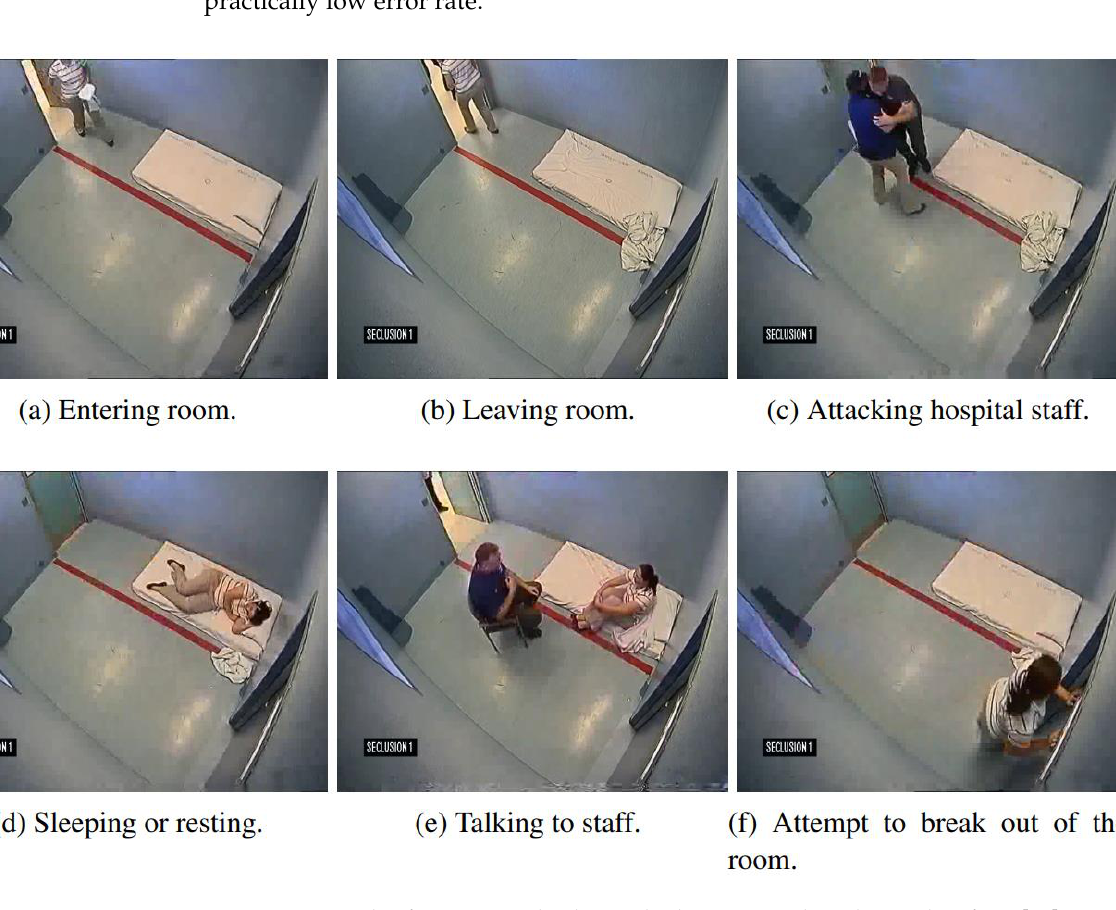
Figure 6. Example of activities to be detected. These images have been taken from [83]